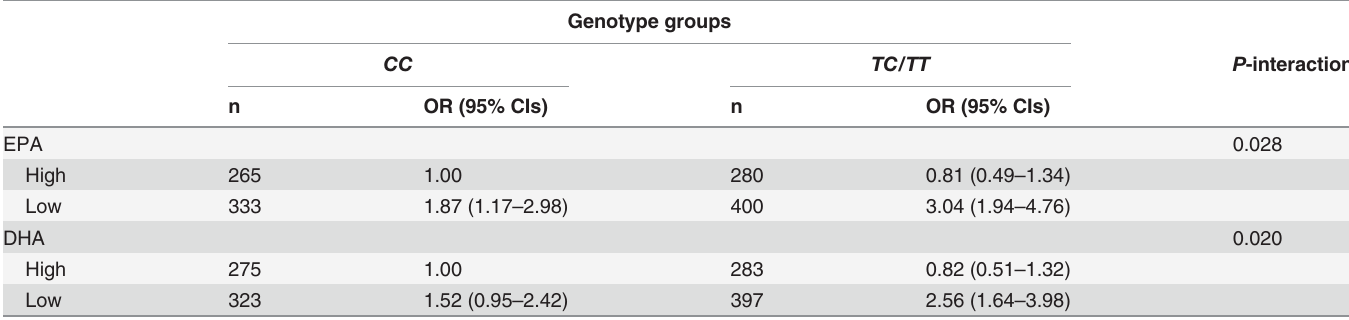
Table 3. Nutrigenetic interaction of EPA and DHA with FADS1 rs174547 on risk of CAD under a dominant genetic model a